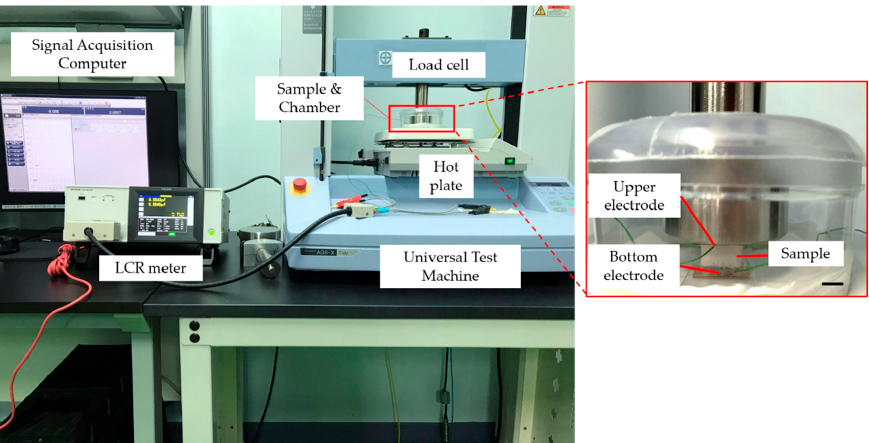
Figure 2. Measuring system for capacitance and mechanical properties of the PU porous structure-based sensor. Scale bar = 10 mm